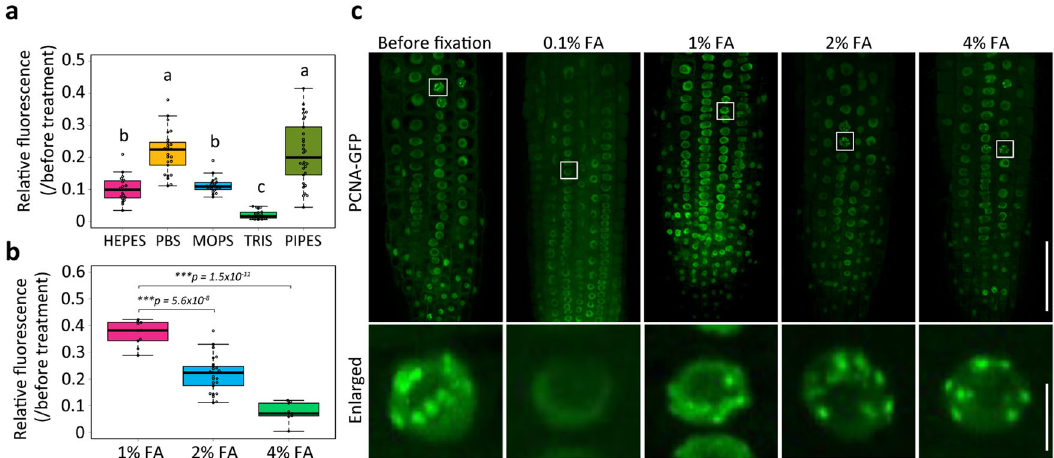
Fig. 3 Consideration of fi xation conditions. a , b Relative fl uorescence intensity was quanti fi ed from GFP fl uorescence images before and after fi xation in HEPES ( n = 20), PBS ( n = 25), MOPS ( n = 20), TRIS ( n = 20), and PIPES ( n = 30) buffers supplemented with 2% FA ( a ) and in PBS buffer supplemented with 1% ( n = 10), 2% ( n = 25), or 4% FA ( n = 10) ( b ) for 1 h. Statistical signi fi cance was evaluated using the Tukey – Kramer method ( a ) and a two-sided Welch ’ s t -test ( b ). The different letters indicate signi fi cant differences at p < 0.05 ( a ). c Confocal micrographs from plants expressing PCNA-GFP fi xed in PBS buffer with 0.1, 1, 2, or 4 FA for 1 h captured using the same microscope settings. The enlarged images are indicated by the white open squares in the respective low-magni fi cation images. Scale bars = 50 μ m at the upper panel and 5 μ m at the lower